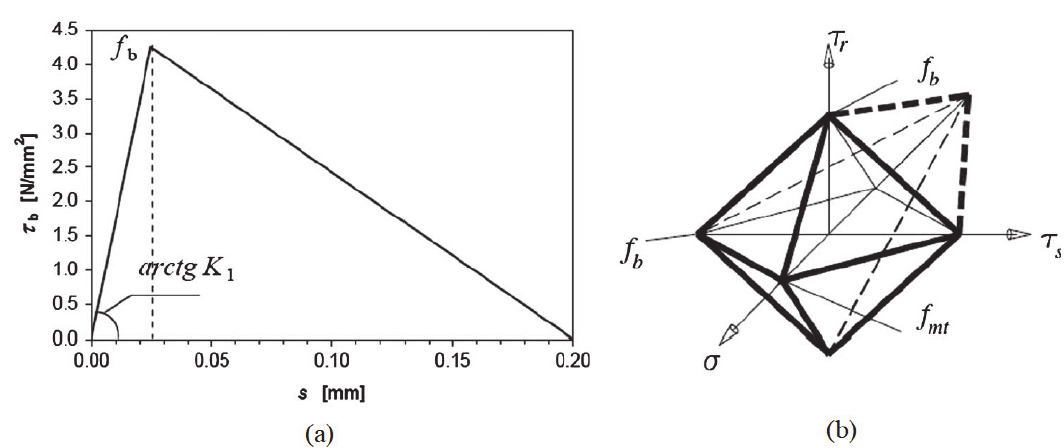
Figure 6: (a) τ b -slip constitutive law; (b) σ - τ s- τ t failure surfaces for masonry-FRP